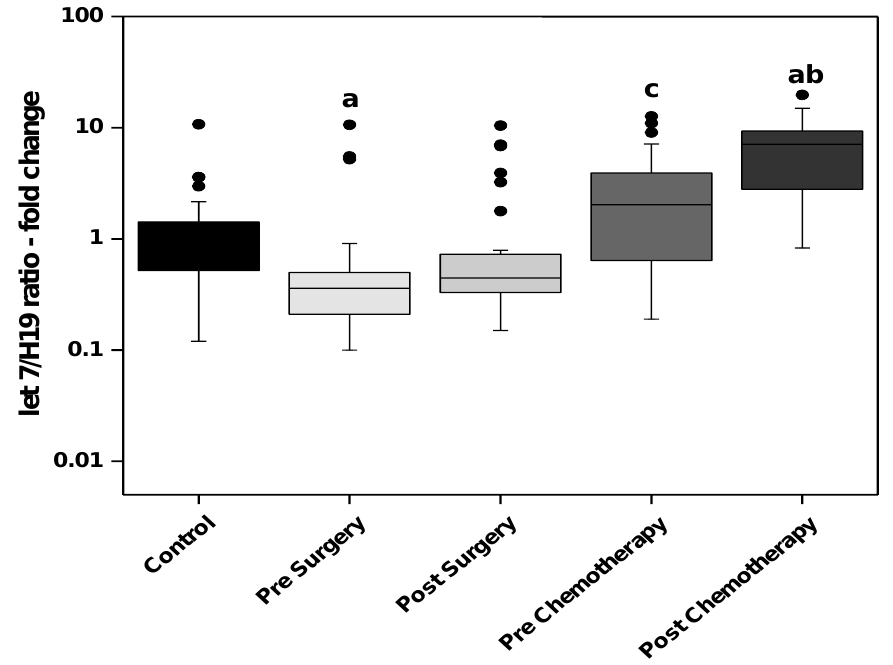
Figure 6. The let 7/H19 ratio in the control subjects and the BC studied groups; surgery only and adjuvant chemotherapy. Extreme value: a — Significant between control and each group by using Post Hoc Test (Dunn ’ s), Kruskal Wallis test, b — Significant between pre and post in same group by using Wilcoxon signed ranks test, c — Significant between post-surgery and prechemotherapy by using Mann Whitney test.